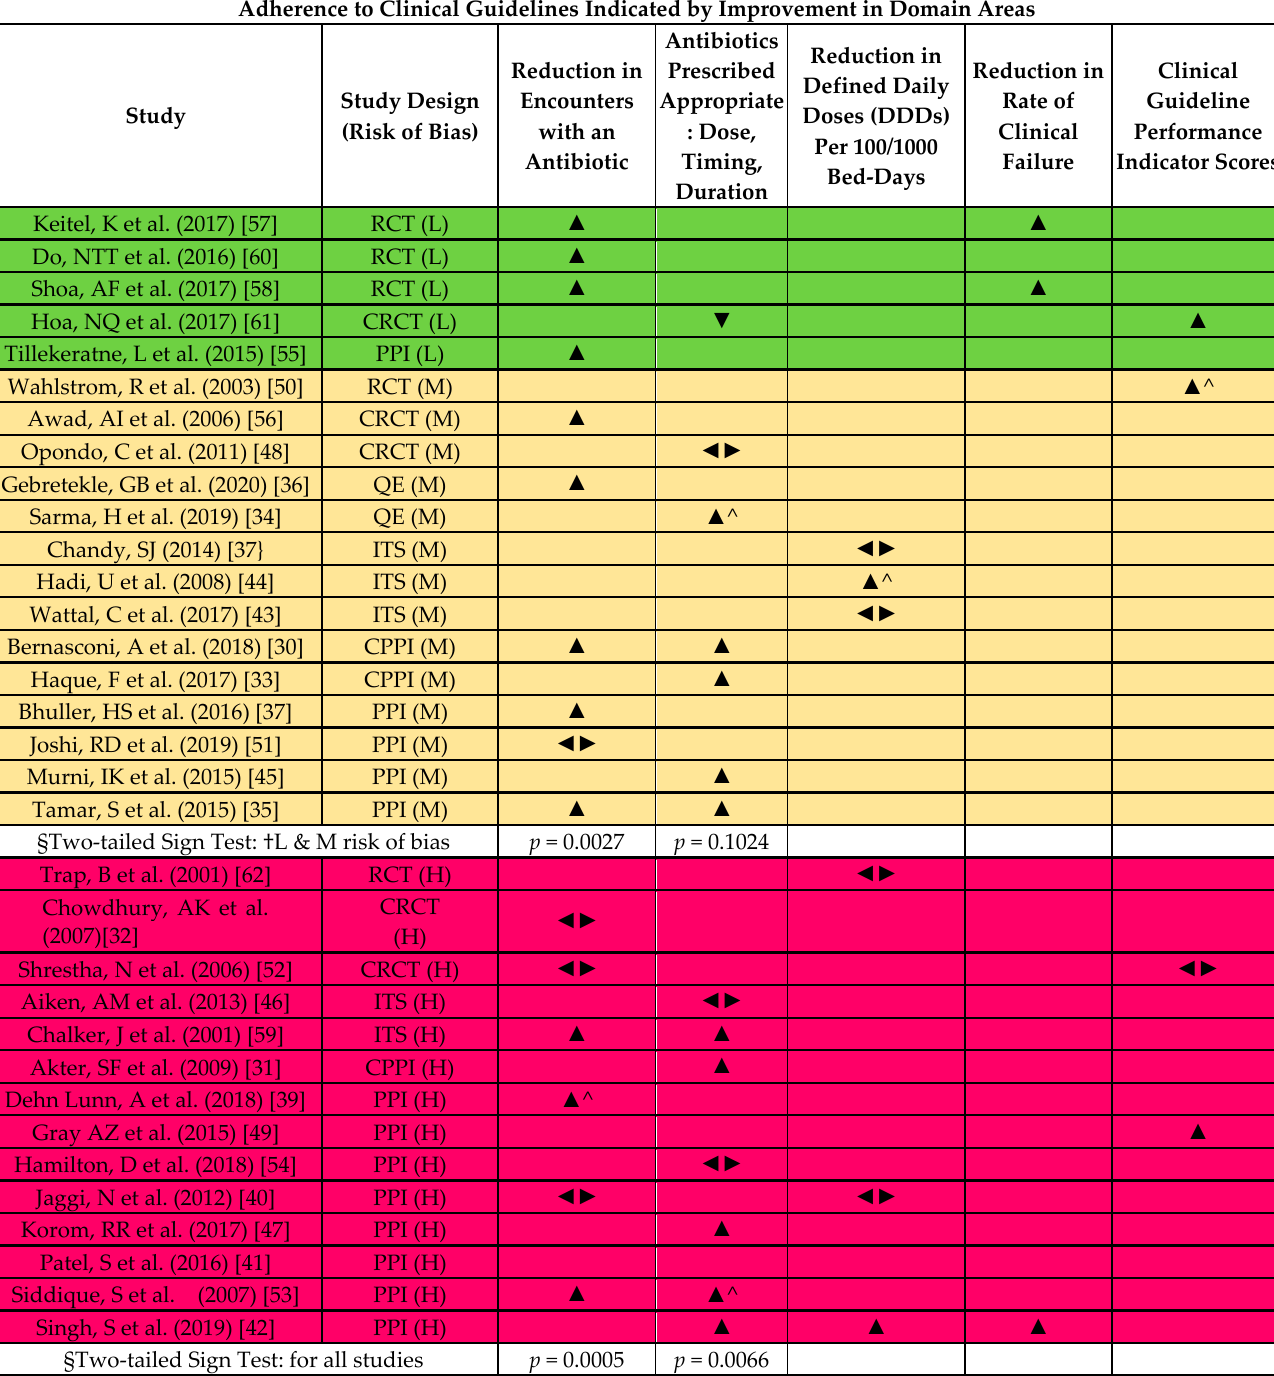
Table 3. Effect direction plot summarising direction of effects of intervention outcomes of strategies used for implementing and promoting adherence to antibiotic guidelines in LLMICs. Adherence to Clinical Guidelines Indicated by Improvement in Domain Areas